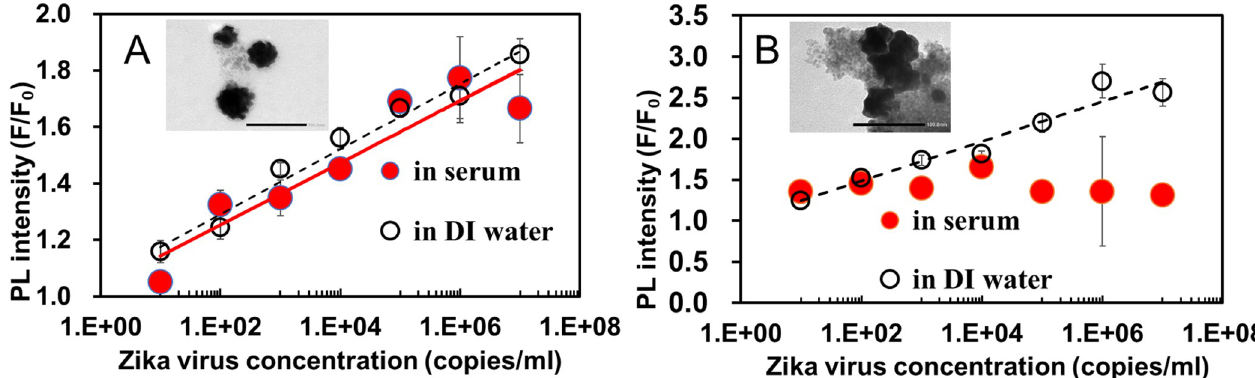
Fig 6. Fluorescence enhancement calibration curve. (A) Ab-MPA-AuNPs and (B) Ab- L -cyst-AuNPs were used to detect ZIKV and insets show TEM images of QD-Ab-ZIKV-Ab-MPA-AuNPs and QD-Ab-ZIKV-Ab- L -cyst-AuNPs, respectively. Detection media are in human serum (closed red circles) and in DI water (open